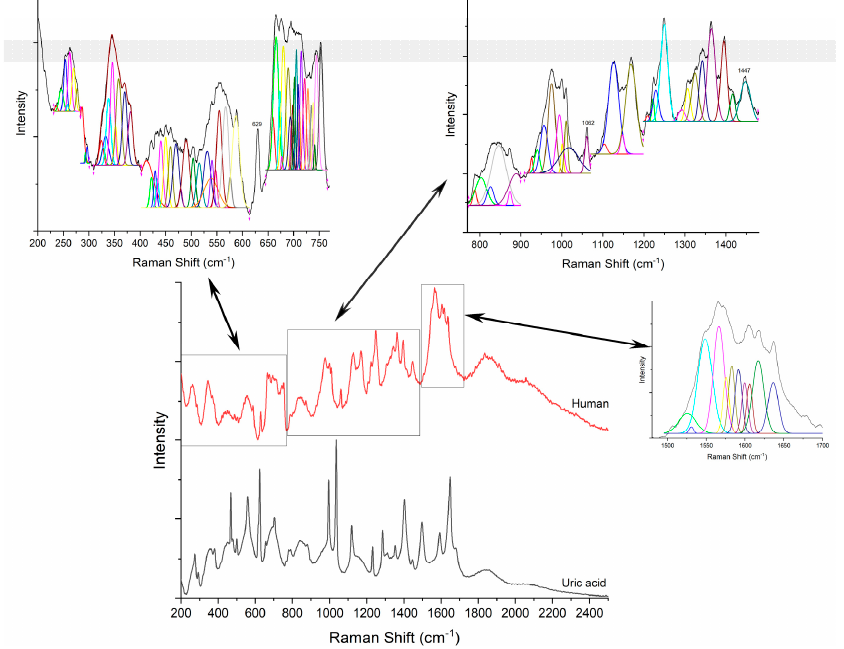
Figure 8. Raman spectra of pure uric acid and, respectively, human sample. Table 1. Raman bands assignments of samples vs. uric acid.